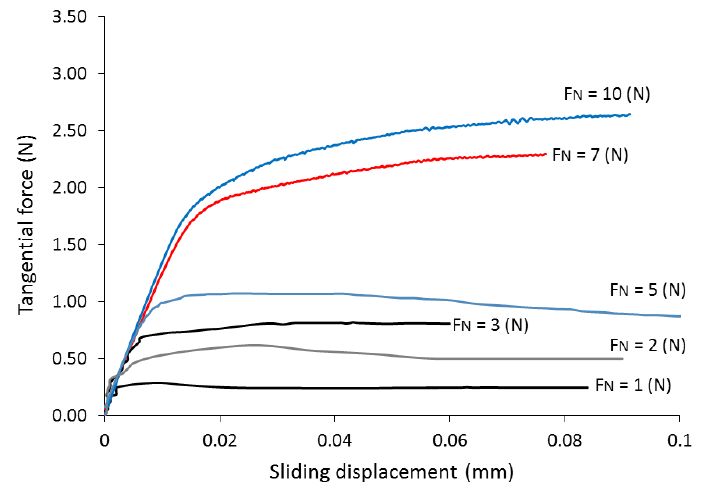
Figure 12. Tangential force–displacement plot at the contacts of LBS grains and the effect of the applied normal load (tests during the first shearing cycle).